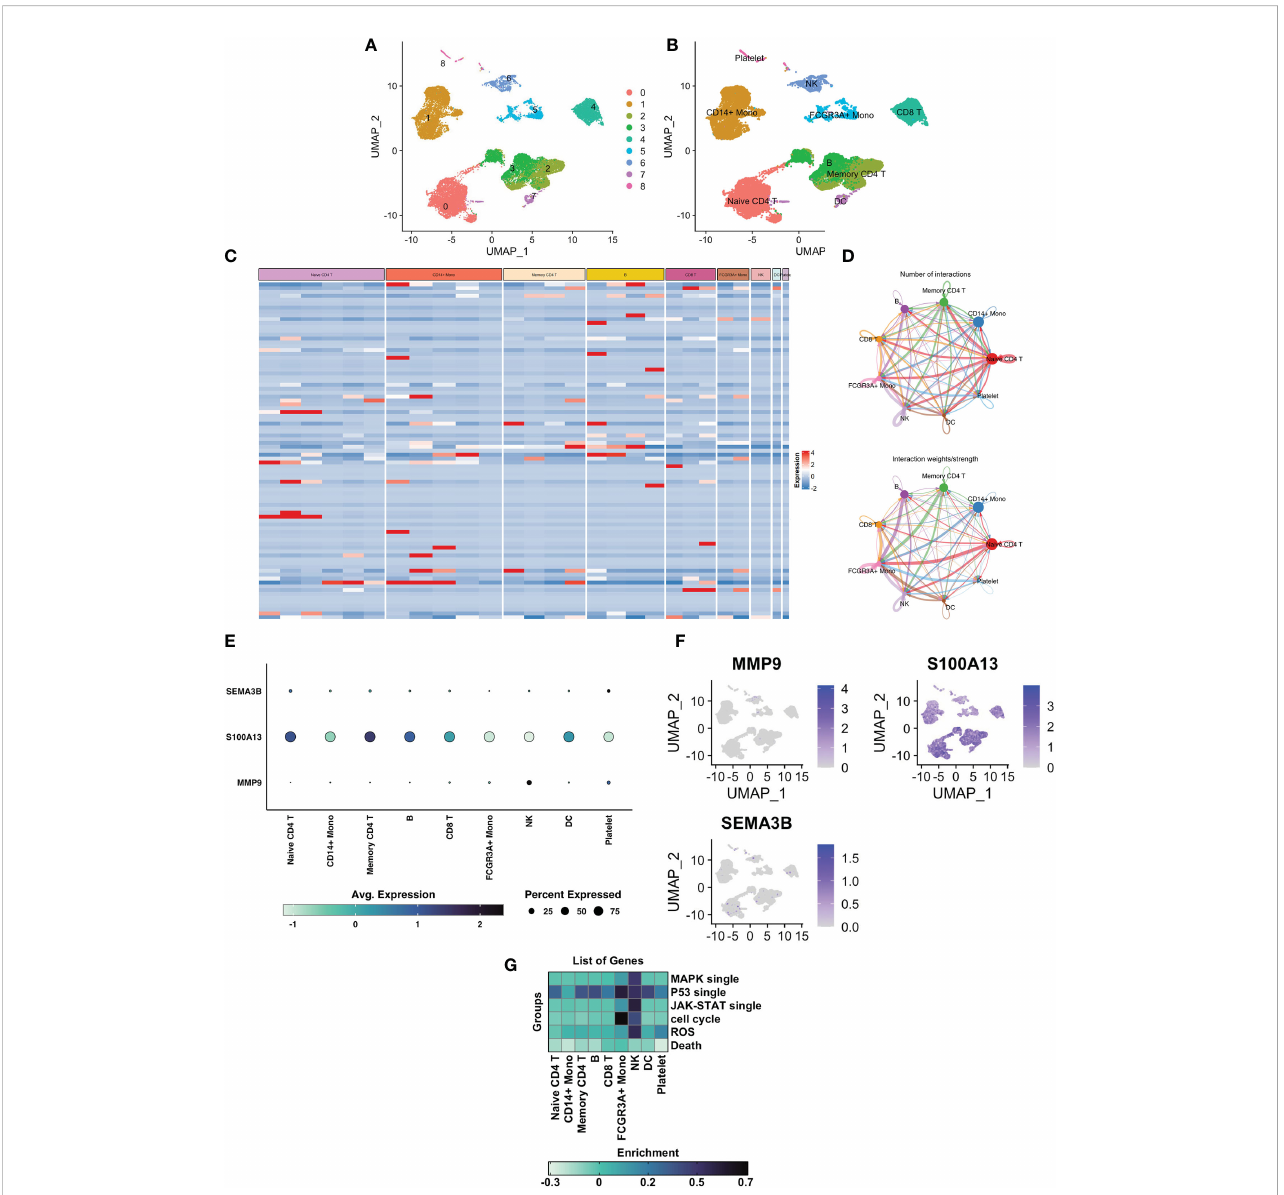
FIGURE 7 Single cell sequencing analysis of GSE139829 and the cell localization of 3 modelling genes. (A) Cluster analysis and dimension reduction. All of the cells in GSE139829 were divided into 9 cell clusters. (B) The cells are classi fi ed as Naive CD4+ T cells, CD14+ Mono cells, Memory CD4+ cells, B cells, CD8+ T cells, Mono cells, NK cells, DC cells, platelet cells based on surface marker genes. (C) Heatmap shows characteristics that are differently expressed in each cell type. (D) A net plot displaying the quantity and intensity of interactions. (E) The three prognostic genes expression levels in the 8 cell types. (F) UMAP plots of the three prognostic genes. (G) Heatmap plot showing the correlation between speci fi c signaling pathways and cell